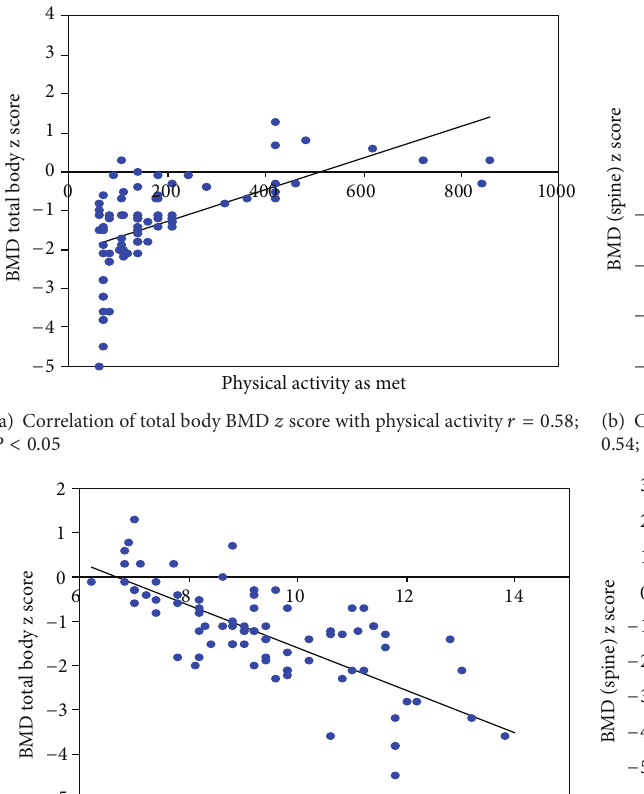
(d) Correlation of lumbar spine BMD 𝑧 score with HbA1C 𝑟 = −0.74 ; 𝑃 < 0.05